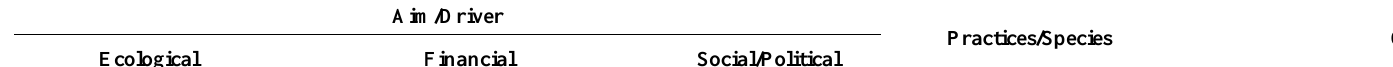
4. Restoration/reforestation aims, practices and challenges for governance in Paraguay’s Privately-Owned Forests and Madagascar’s Co-managed State